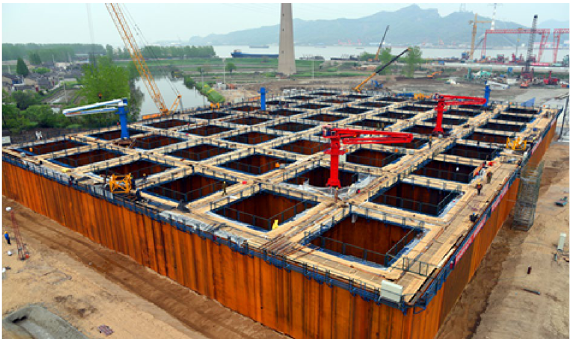
Figure 1. Wufeng mountain Yangtze river bridge’s north anchorage